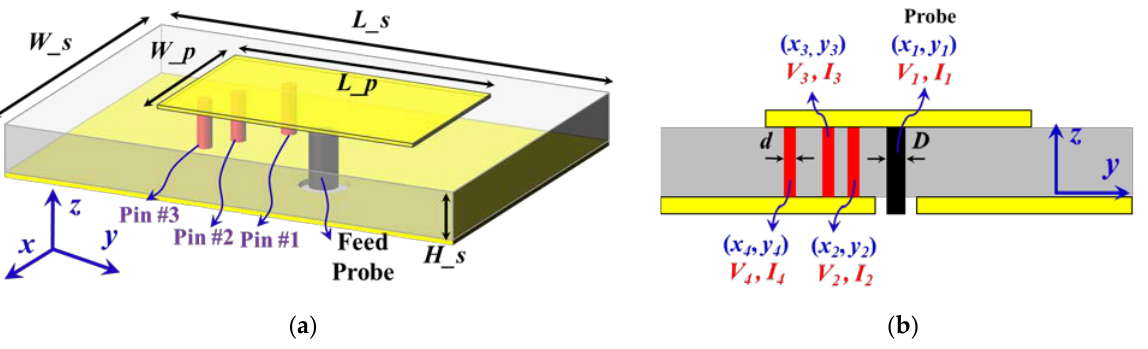
Figure 1. ( a ) Three-dimensional view and ( b ) side view of a regular microstrip antenna employing three shorting pins with dimensions of (mm): W_s = 5.7, L_s = 7.5, H_s = 0.762, W_p = 3.3, L_p = 4.3, d = 0.2, D = 0.3, x 1 = 1.1, x 2 = − 1.3, x 3 = 0, x 4 = 0.71, y 1 = 0, y 2 = − 0.8, y 3 = − 1.8, y 4 = −